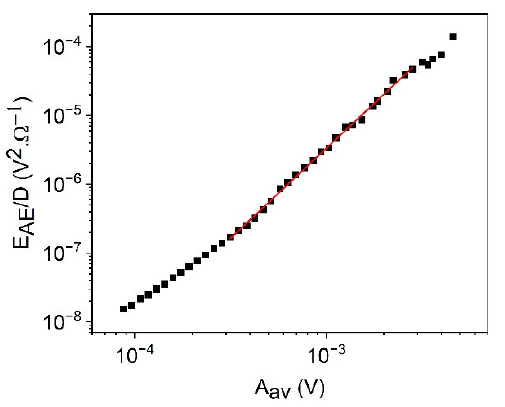
versus logA av plot for heating in alloy B (at B = 0). The slope is 2.30 ± 0.05. Figure 10.    versus   plot for heating in alloy B (at B = 0). The slope is 2.30 ± 0.05. Figure 10. log E AE D